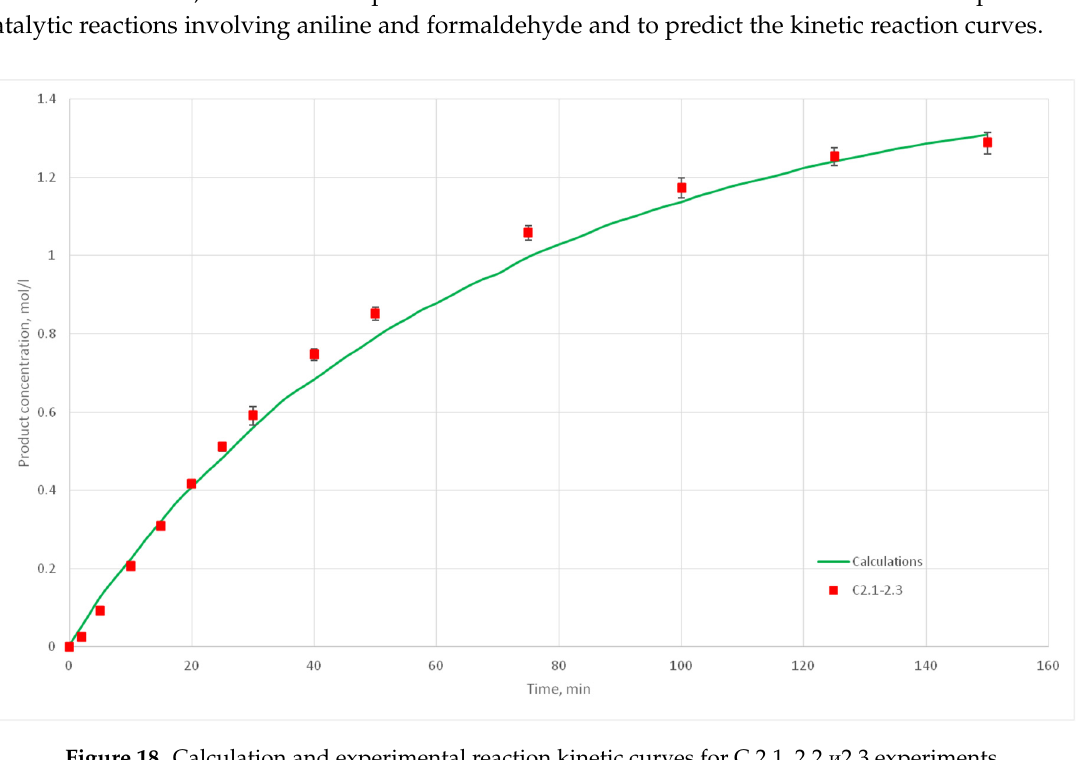
Figure 18. Calculation and experimental reaction kinetic curves for С 2.1, 2.2 и 2.3 experiments.